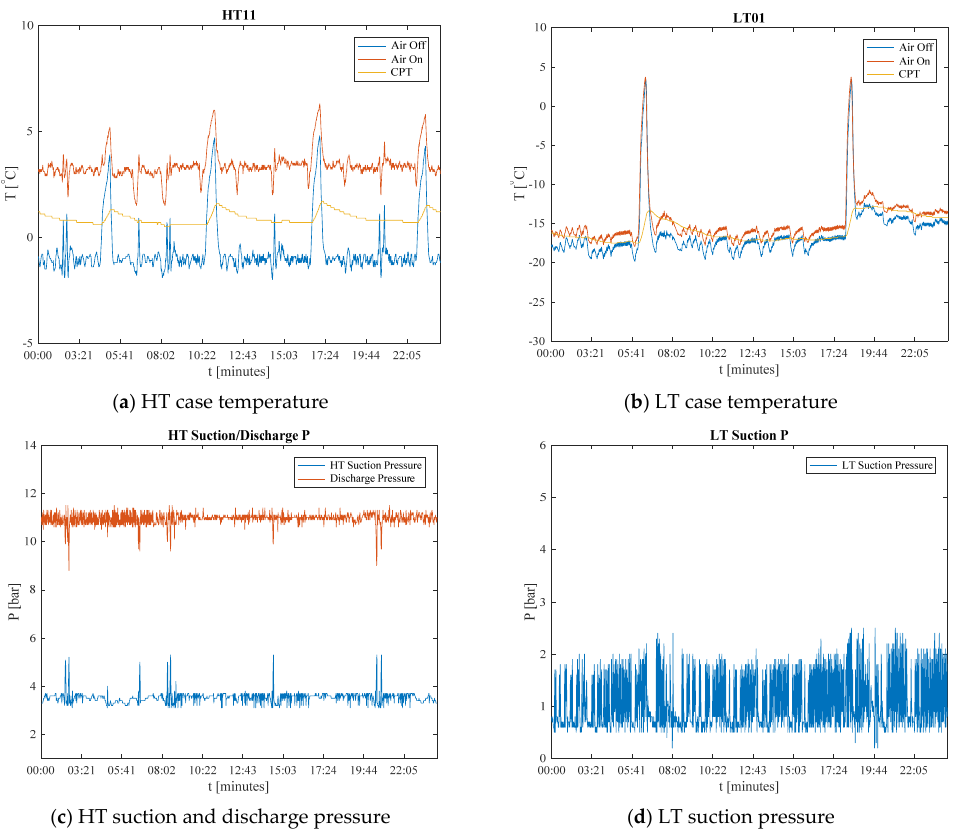
Figure 4. Probe data recorded for 24 h of normal operation of the refrigeration system.